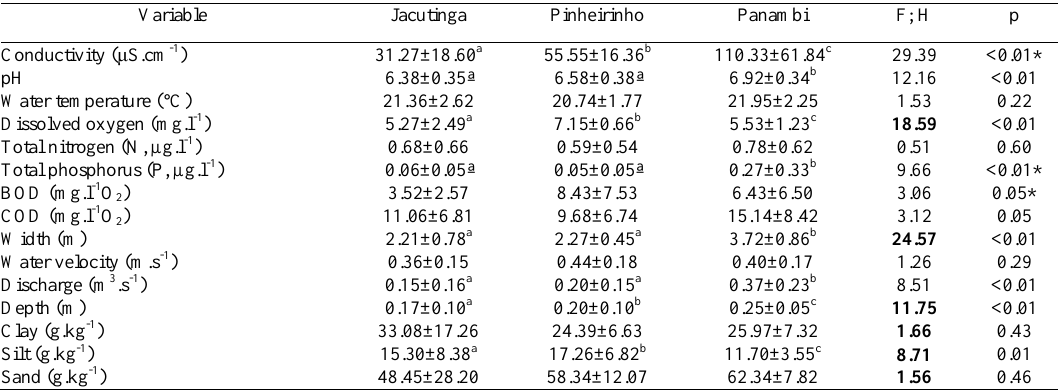
Table 4. Summary of physical, chemical and morphometric variables (mean ± SD) measured in urban streams (Jac, Jacutinga; Pin, Pinheirinho; Pan, Panambi) in the city of Toledo, State of Paraná, southern Brazil, based on samples collected from December 2007 to December 2008 (BOD: biochemical oxygen demand; COD: chemical oxygen demand). Results of the analysis of variance for each variable (values in italic, H - Kruskal-Wallis) are also presented. Values in boldface and letters in superscript indicate significant spatial differences along the urbanization gradient (Tukey test and Dunn test; p < 0.05). F; H = F and H statistic; p = significant level. *Data rank transformed.